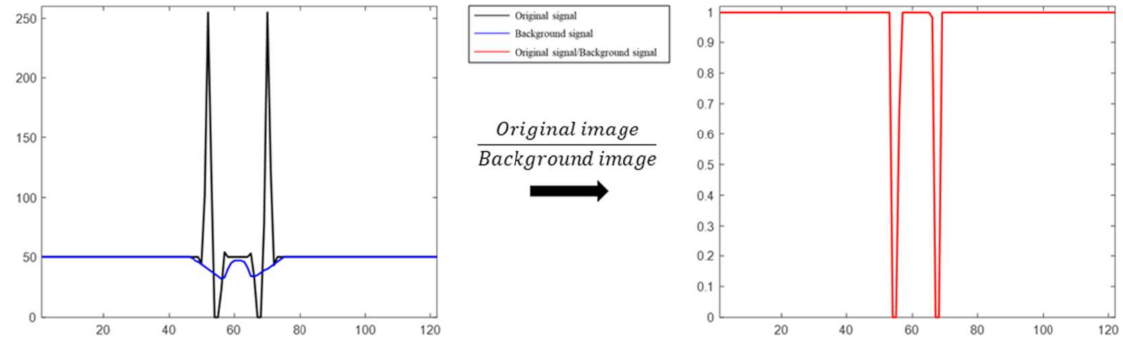
Figure 4. Cell signal after background